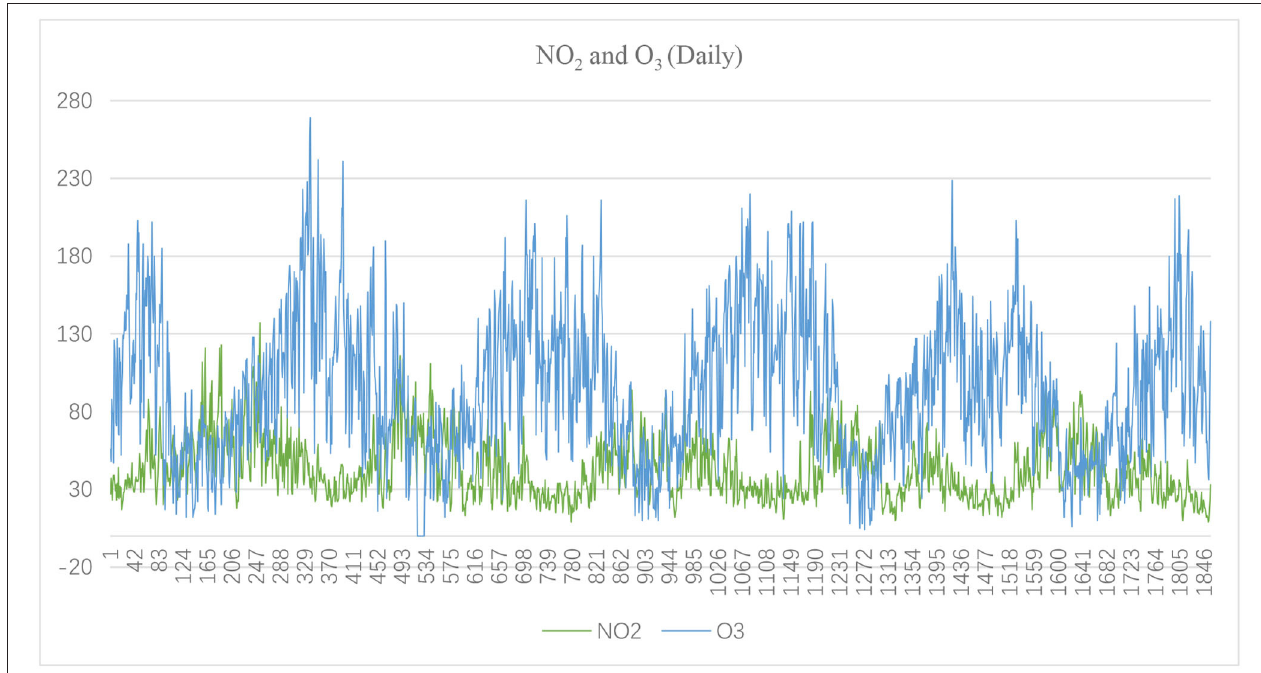
FIGURE 2 | Daily NO 2 and O 3 of Hefei from July 2016 to July 2021( µ g/m 3 ).